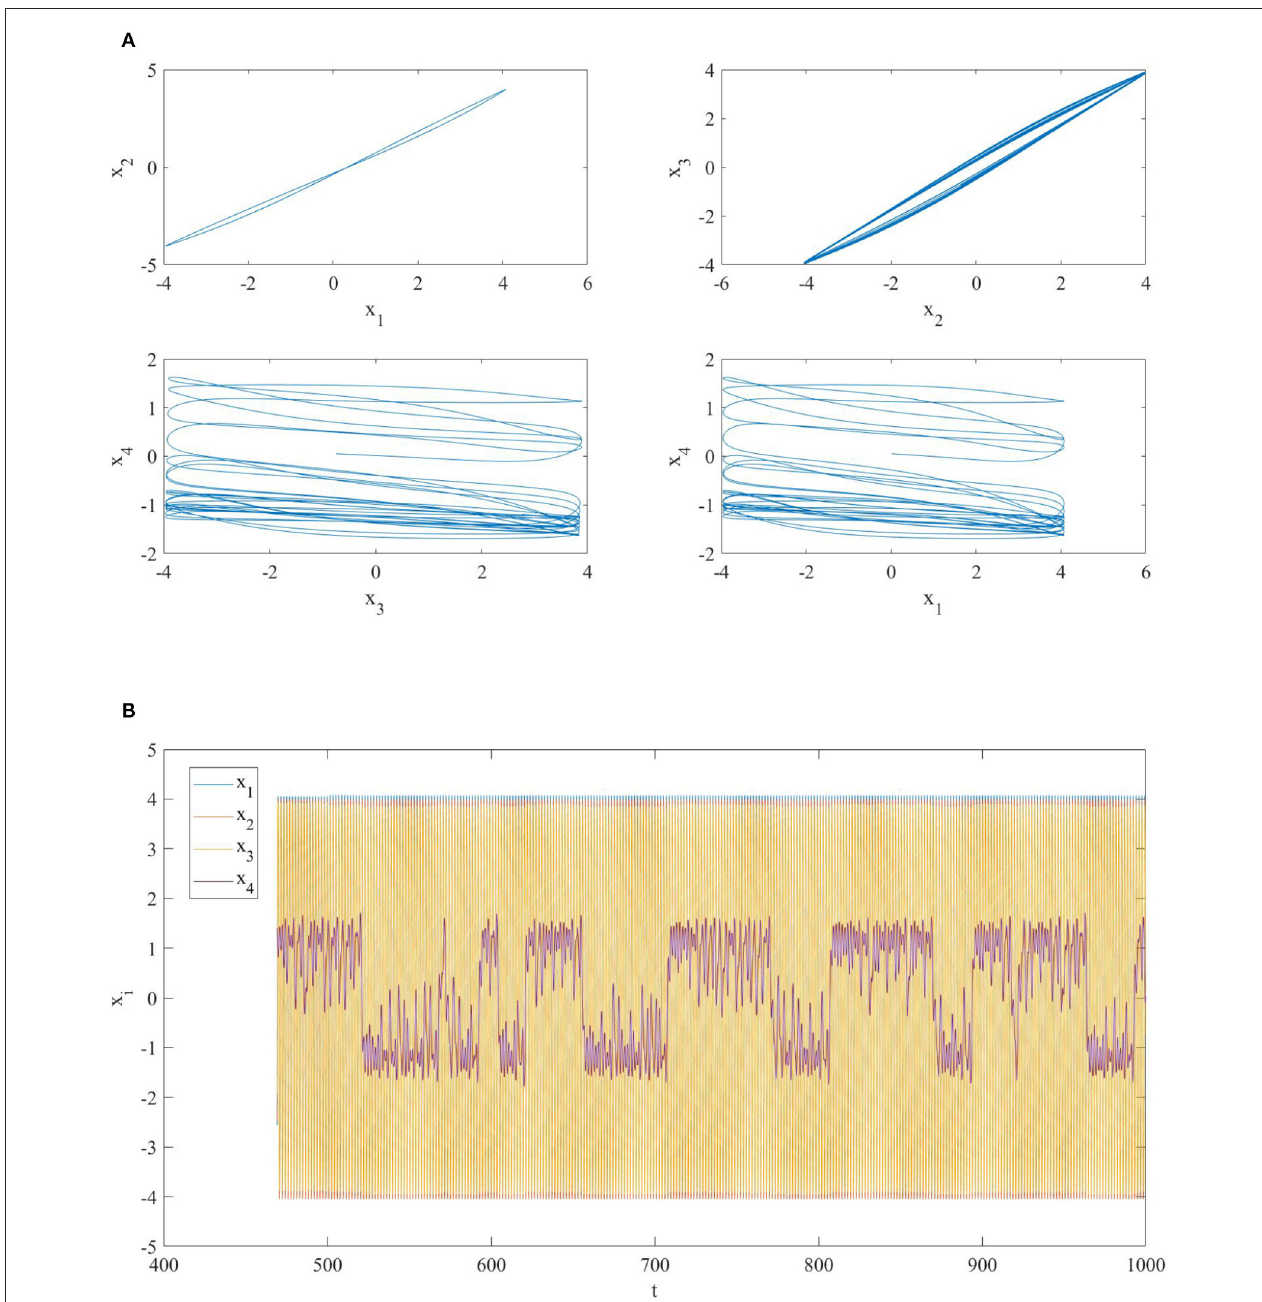
FIGURE 3 | (A) Phase portrait and (B) time series of a network of four diffusively coupled MOCs when a link between the first and the third oscillator is added at t = 500. The oscillators in the network are not synchronized. the NMOC for any t ≥ 500 takes place on the invariant = ( Q ′ manifold M c ( Q ′ ), where Q ′ , . . . , Q ′ ) with 0 0 0,1 0,4